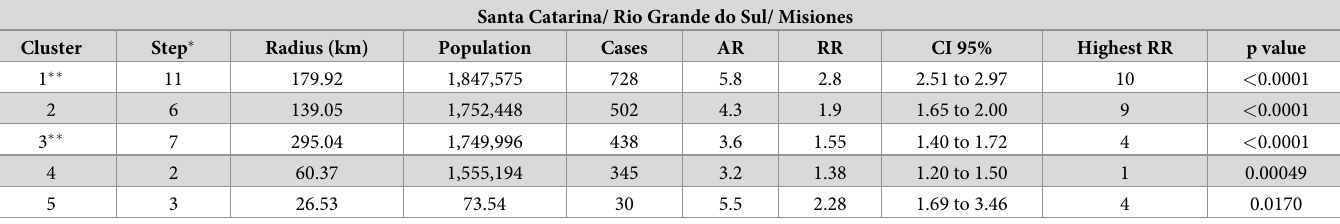
Table 4. Description of areas of relative risk for new cases of leprosy in the states of Santa Catarina, Rio Grande do Sul and Misiones, Argentina, 2010 to 2016.